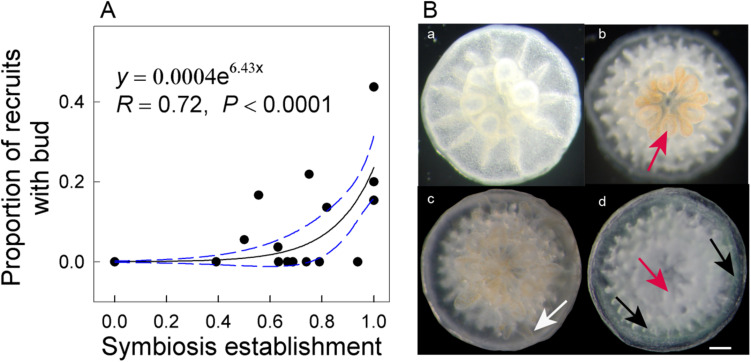
Exponential relationship between symbiosis establishment and budding rates of Acropora intermedia after 33 days (A). Developmental stages of A. intermedia after settlement (B). (a) One-day-old aposymbiotic polyp, (b) 7-day-old polyp with visible symbionts within oral disk and tentacles, (c) 28-day-old small colony with a new bud (white arrow) in the periphery area, (d) 28-day-old recruit with normal translucent (red arrow) and green fluorescent tissues (black arrows). Scale bar = 1 mm. Note: each data point represents an individual Petri dish.